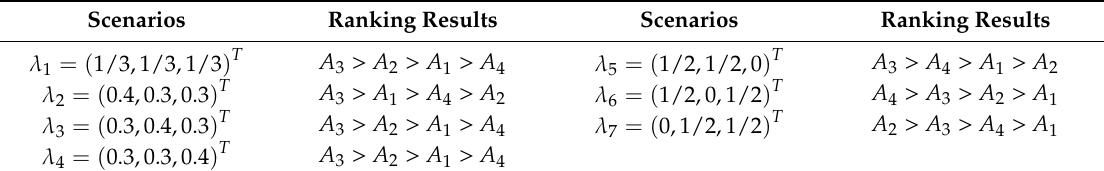
Table 6. The ranking results associated with the di ff erent weights of the subgroups. Scenarios Ranking Results Scenarios Ranking